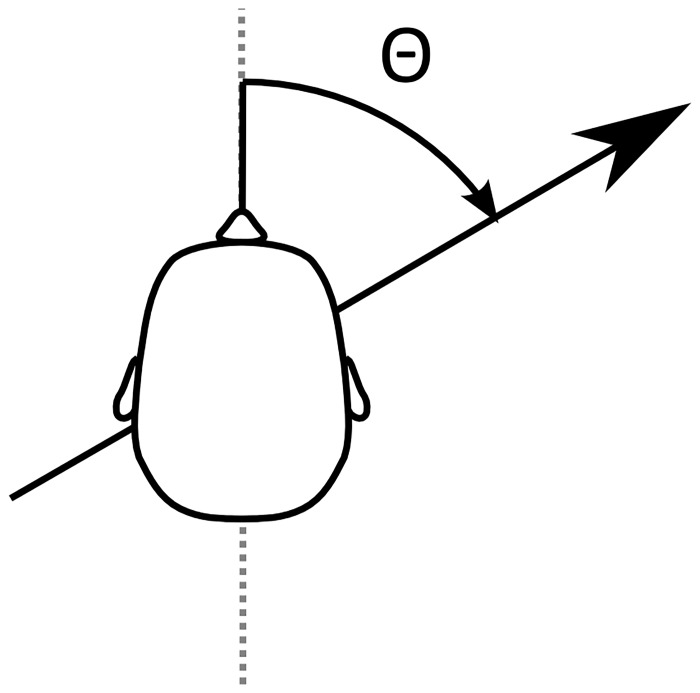
Operationalization of heading angle.The participant was oriented at angle θ relative to the simulator motion path (represented by black arrow). For straight ahead motion, the participant’s naso-occipital axis (dashed gray line) would be aligned with the simulator motion path.